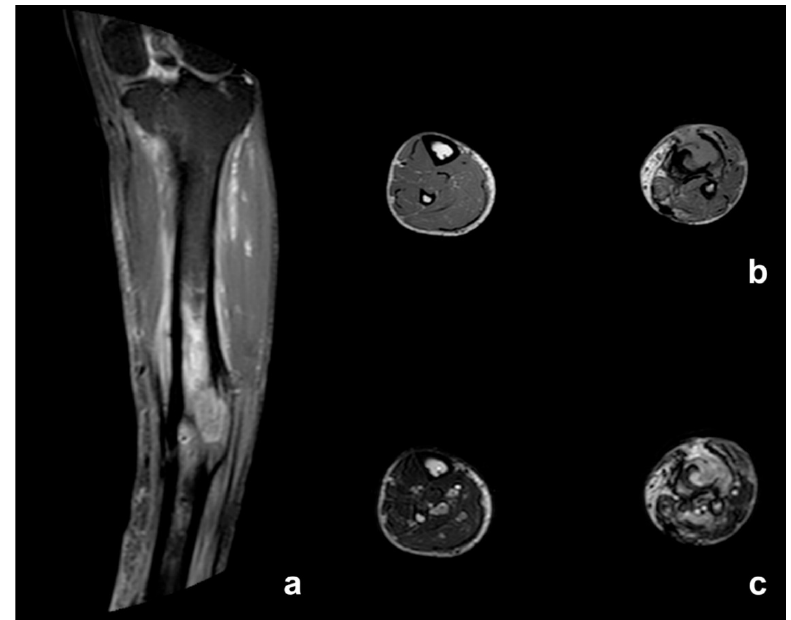
Figure 3. Pre-debridement non-contrast MRI. ( a ) Cor STIR shows periosteal thickening of the left tibial cortex and intramedullary edema around the pseudonodular area of intermediate intensity signal. ( b ) Tra T1w displays periosteal thickening of the posterior cortex of the left tibia and double sinus tract that leads from medullary cavity to surrounding soft tissues. ( c ) Tra T2w shows intramedullary high signals extending along sinus tracts, described as intra-extraosseous